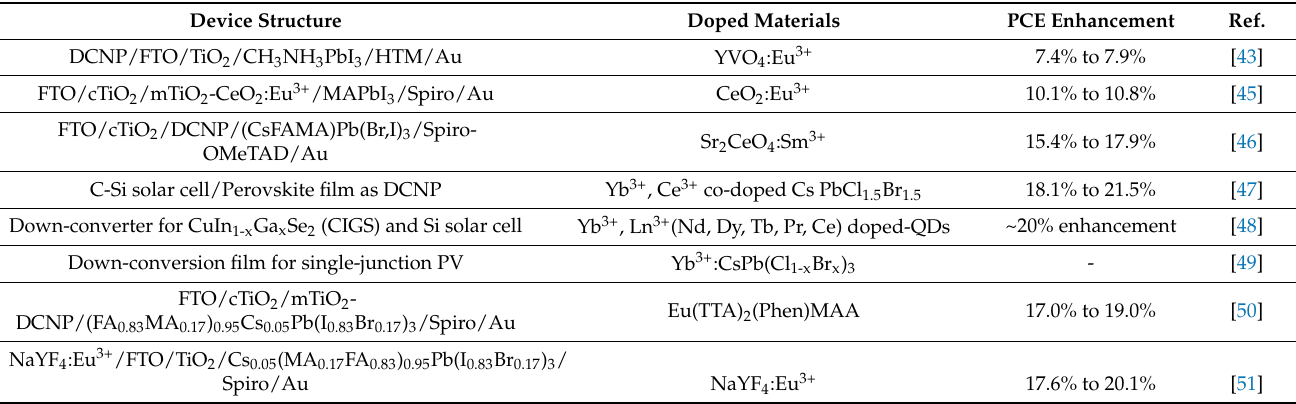
Table 2. The PCE enhancement of down-conversion Ln 3+ -doping solar cell